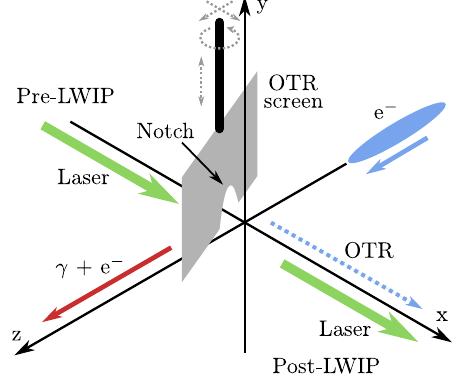
FIG. 6. Schematic of the beam geometry at the laserwire interaction point, including the OTR screen at 45° to the electron beam direction, incoming electron bunch, outgoing electron bunch, OTR path, laser beam path, and Compton-scattered photons ( γ ).